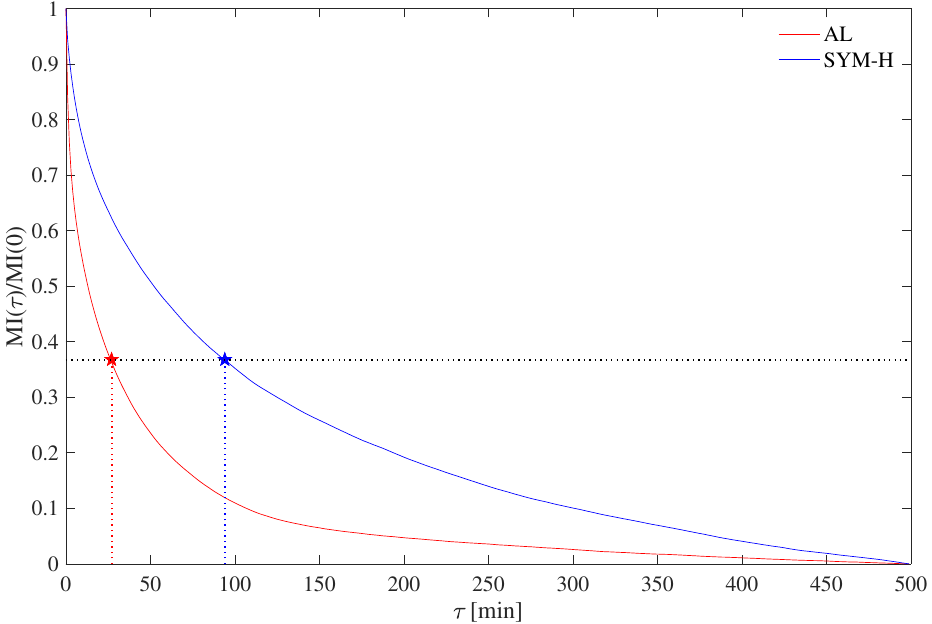
Figure 3. Normalized auto-mutual information functions MI ( τ ) /MI ( 0 ) for AL (red) and SYM-H (blue), respectively. The stars represent the chosen embedding delays ∆ as those values at which MI ( τ ) /MI ( 0 ) = e − 1 , the latter reported by the horizontal dotted line. The two dotted vertical lines from the star symbols visually highlight the choices of ∆